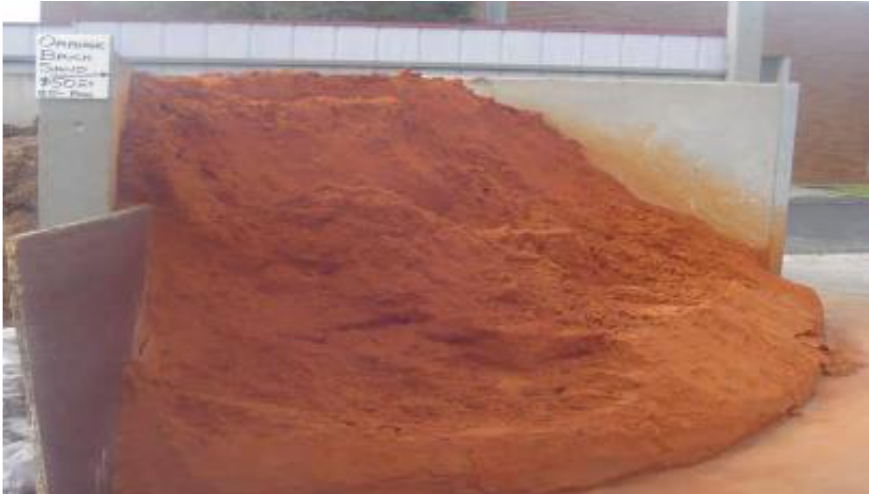
Figure 1. Skye sand sample at the supplier’s site.